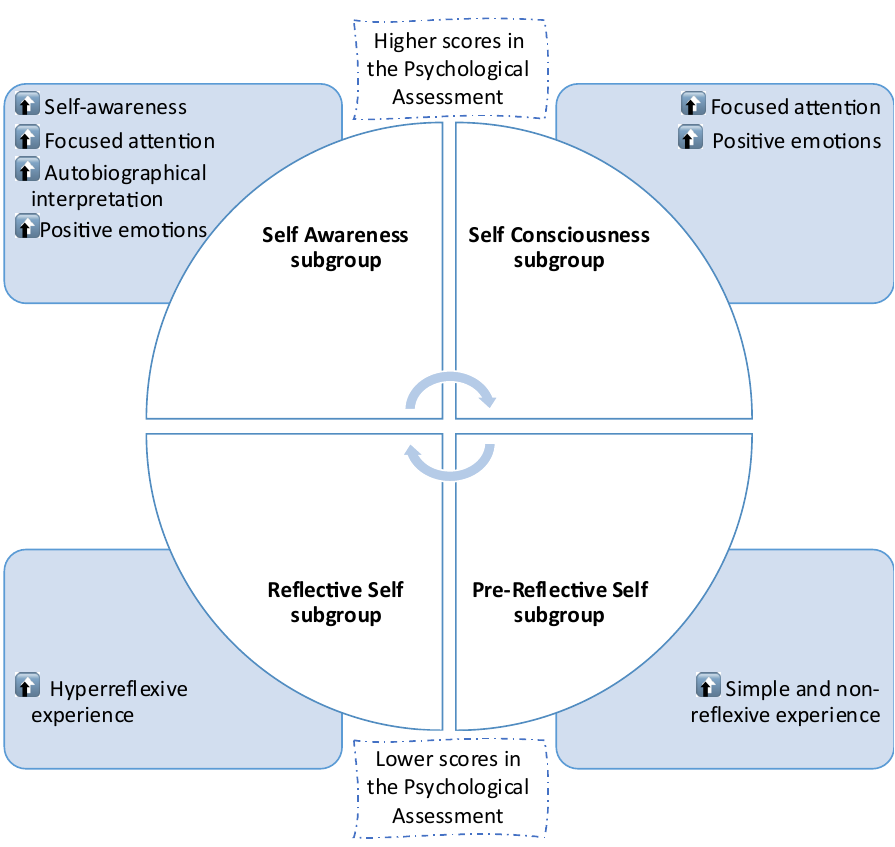
Figure 10. Mental health subphenomes in a neurotypical sample. A diagram is presented for the characterization of 4 the mental subphenomes isolated by the Psychological Assessment: i. the Self Awareness subgroup; ii. the Self Consciousness subgroup; iii. the Reflective Self subgroup, and the iv. the Pre-Reflective Self subgroup. The neurotypical sample is divided into four functional subgroups depending on the psychological assessment scores. A brief description of the mental status of each functional subgroup is presented.